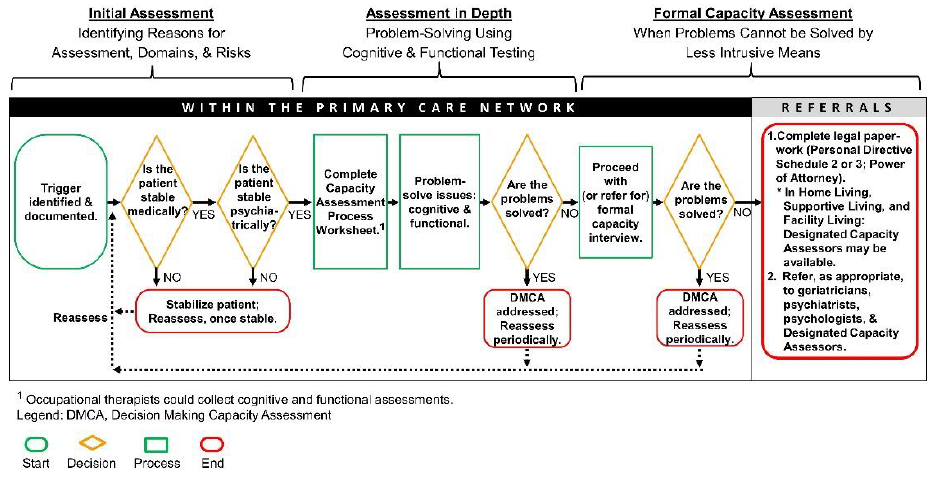
Figure 1. Capacity assessment process.